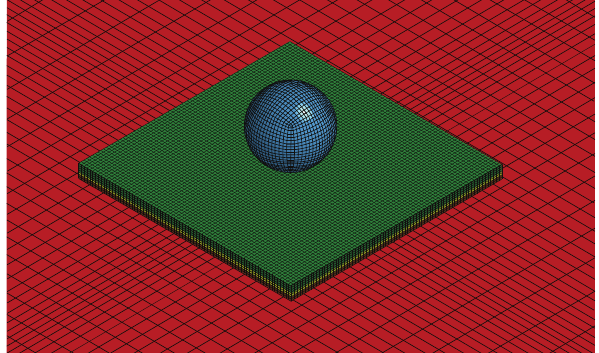
Figure 4: Finite element mesh for rubber ball and tested panel on the RC